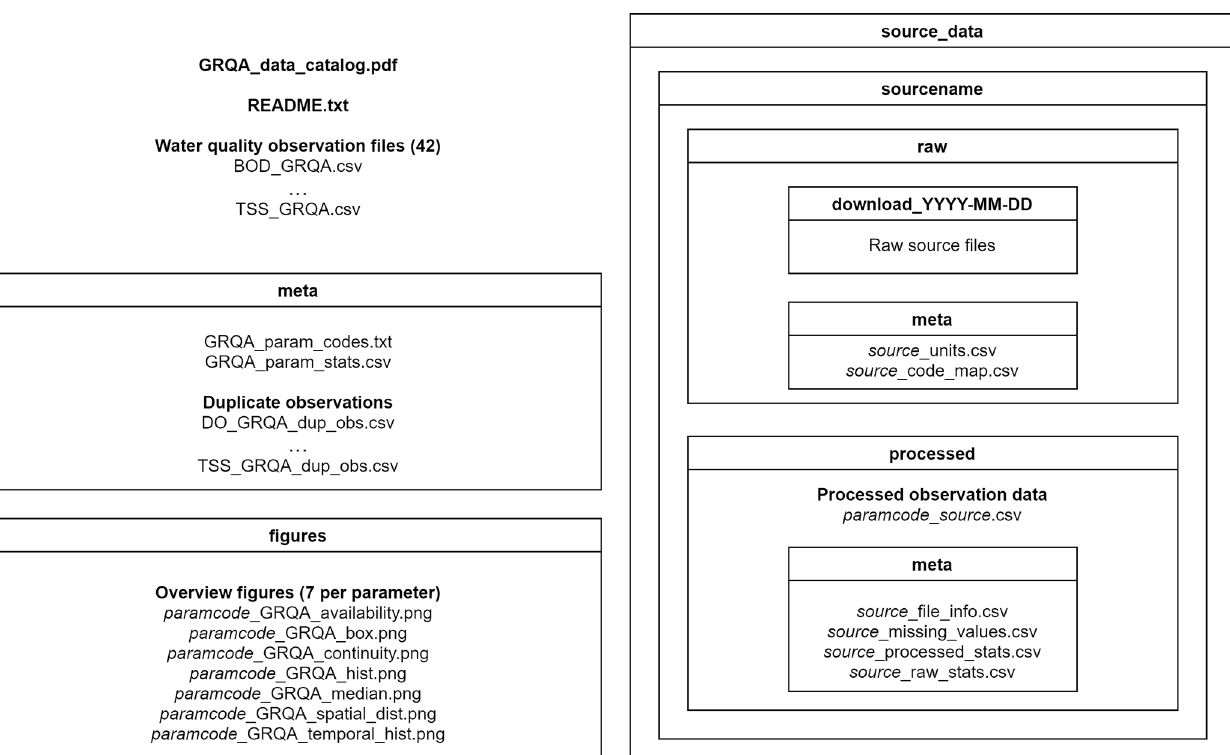
Figure 1. Diagram showing the folder structure and contents of the GRQA